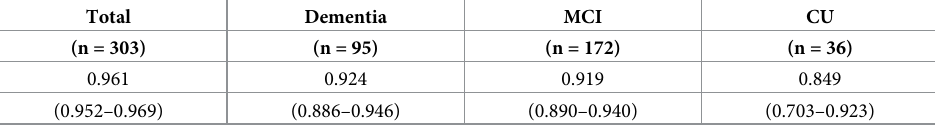
Note. Values are presented as intraclass correlation coefficients (95% confidence intervals).